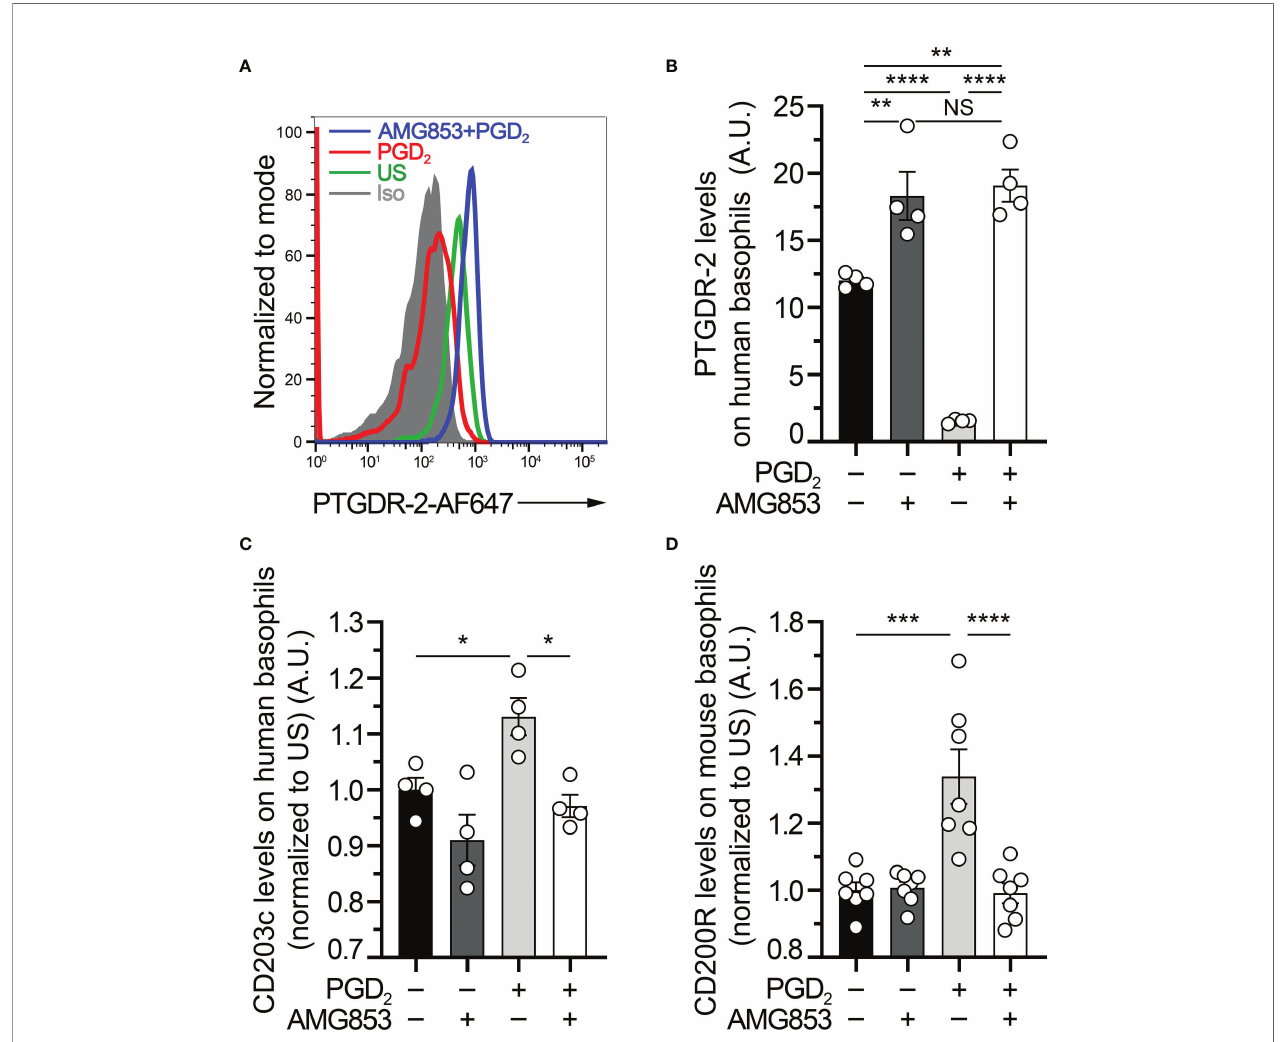
FIGURE 1 | AMG853 blocks ex vivo prostaglandin D 2 (PGD 2 )-induced basophil activation. (A) Representative FACS analysis of the expression levels of PTGDR-2 (also CD294 or CRTH2) on puri fi ed human blood basophils (as described in Materials and Methods ) after 20 h of incubation without ( − ) or with (+) 1 µM PGD 2 and with or without 1 µM of the bispeci fi c PTGDR-1 and PTGDR-2 antagonist AMG853. Gray- fi lled histogram : isotype control signal; green line : unstimulated (US) control; red line : PGD 2 -stimulated basophils; blue line : AMG853-treated and PGD 2 -stimulated basophils. Human basophils were de fi ned as Fc ϵ RI a + CD123 + CCR3 + cells. (B) PTGDR-2 levels on puri fi ed human basophils treated as indicated in (A) . (C) CD203c levels on puri fi ed human basophils treated as indicated in (A) and normalized to the mean of the US conditions. (D) CD200R1 (CD200R) levels on mouse basophils from splenocytes from wild-type (WT) mice incubated for 20 h